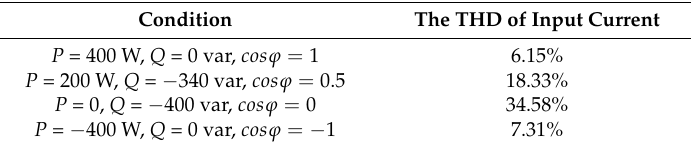
Figure 12. The experimental waveform of the presented converter operating in the discharging mode under a unity power factor ( P = − 400 W, Q = 0 var, cos ϕ = − 1 ). Table.4. The THD values of input current under different conditions.